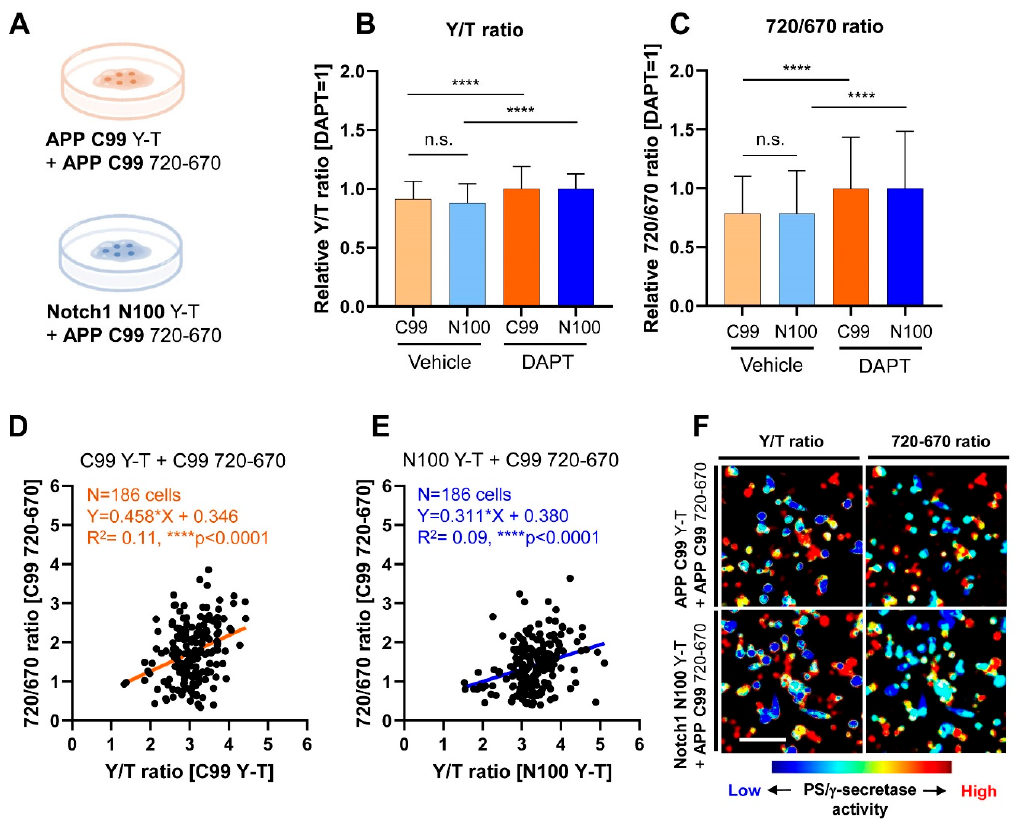
Figure 1. Co-recording of APP C99 and Notch1 N100 processing by PS/ γ -secretase on a cell-by-cell basis in live cells: ( A ) A schematic presentation of the experimental conditions. The APP C99 720-670 biosensor was co-transfected with either the APP C99 Y-T or Notch1 N100 Y-T biosensor in CHO cells; ( B ) CHO cells co-expressing the C99 720-670 with C99 Y-T biosensors or those with the N100 Y-T biosensors were treated with 1 µ M DAPT (PS/ γ -secretase inhibitor) or vehicle control for 16 h. Y/T ratios in the cells expressing the C99 Y-T biosensor were normalized to those in the corresponding DAPT-treated cells and similarly done for the cells expressing the N100 Y-T biosensors to calculate relative Y/T ratios, which indicate the processing efficiency of the reporter probe by PS/ γ -secretase. The relative Y/T ratio was not different between the cells co-expressing the C99 720-670 with C99 Y-T biosensor and those with the N100 Y-T in vehicle-treated condition. n = 186–188, one-way ANOVA, n.s. not significant, **** p < 0.0001; ( C ) In accordance, relative 720/670